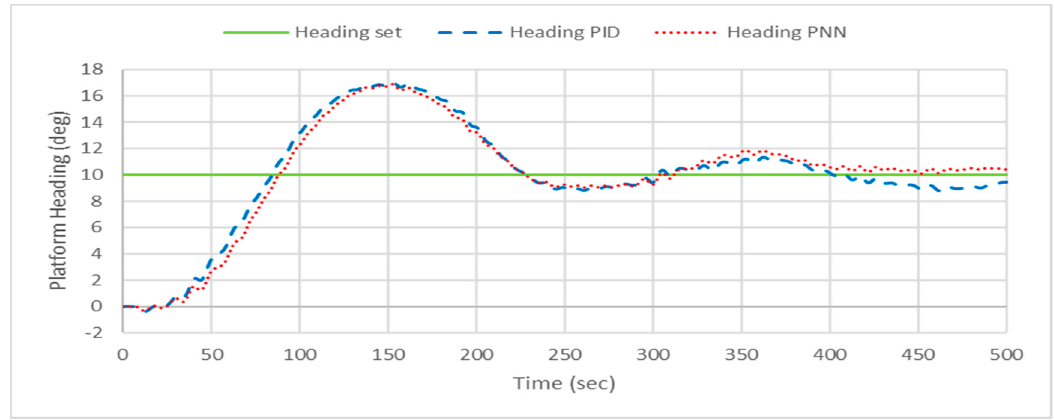
Figure 16. DP simulation with PID and PNN controls showing platform heading (Head sea).